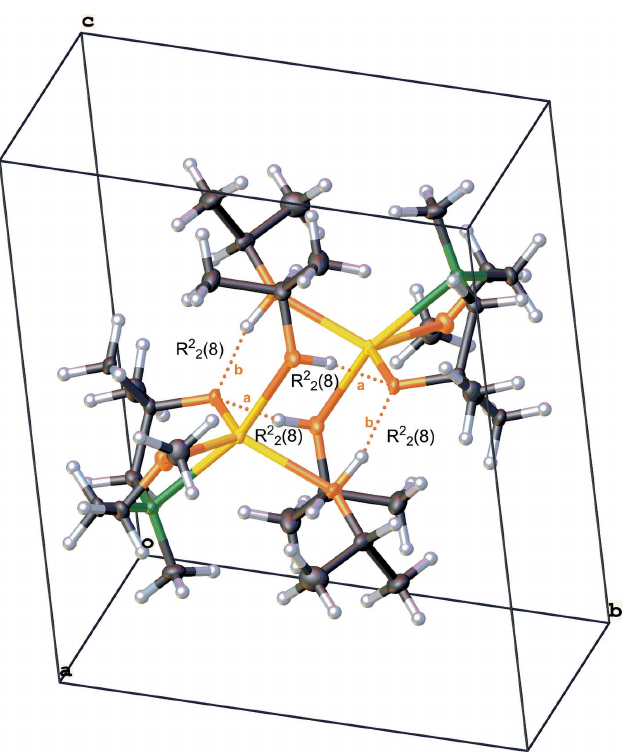
Figure 3 View of the unit cell of 2 , Hydrogen bonding is shown and the graph-set motifs are labelled ( Mercury; Macrae et al. , 2008). Symmetry operation a = 1 (cid:3) x , 1 (cid:3) y , 1 (cid:3) z .